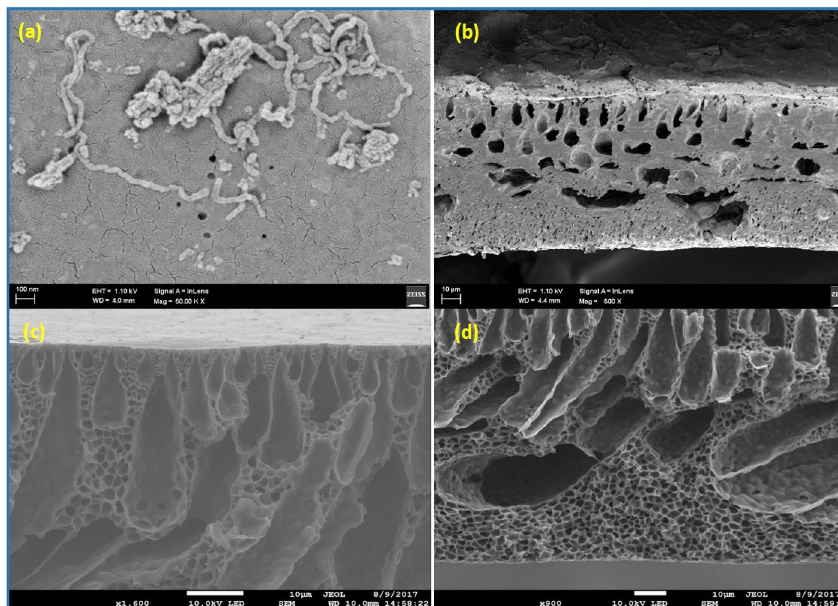
Fig. 4 ( a ) membrane after coating by CNM/PAC, ( b ) cross section, ( c ) top, showing the finger-like structure, and ( d ) bottom, showing the sponge- like